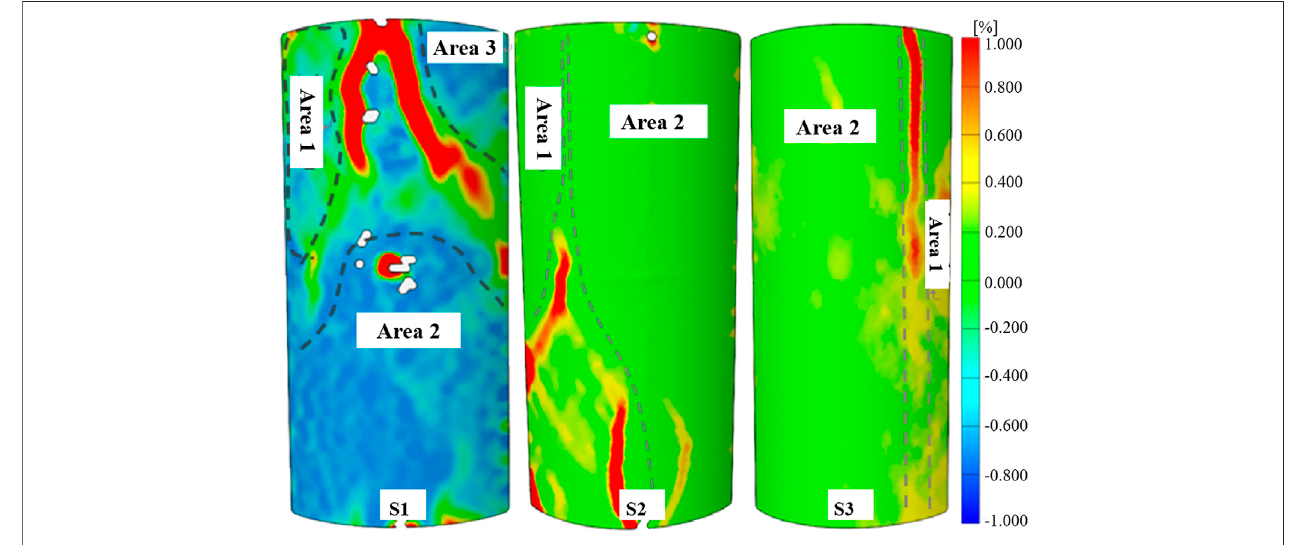
FIGURE 7 | Region division of rock specimen.